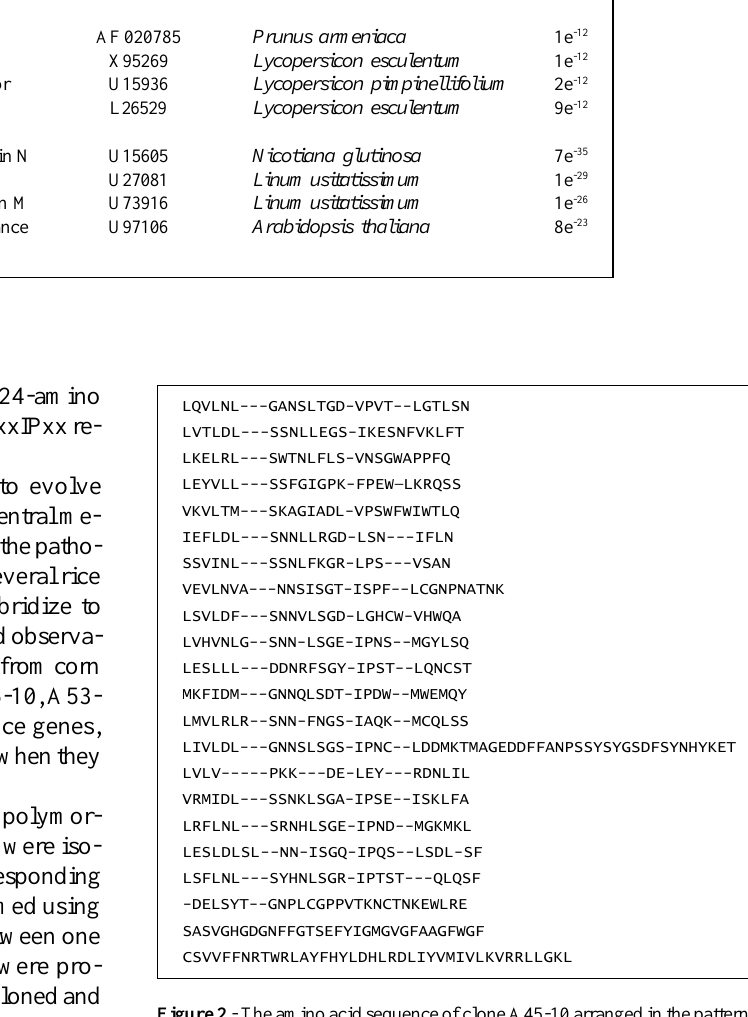
Figure 2 - The amino acid sequence of clone A45-10 arranged in the pattern of leucine-rich